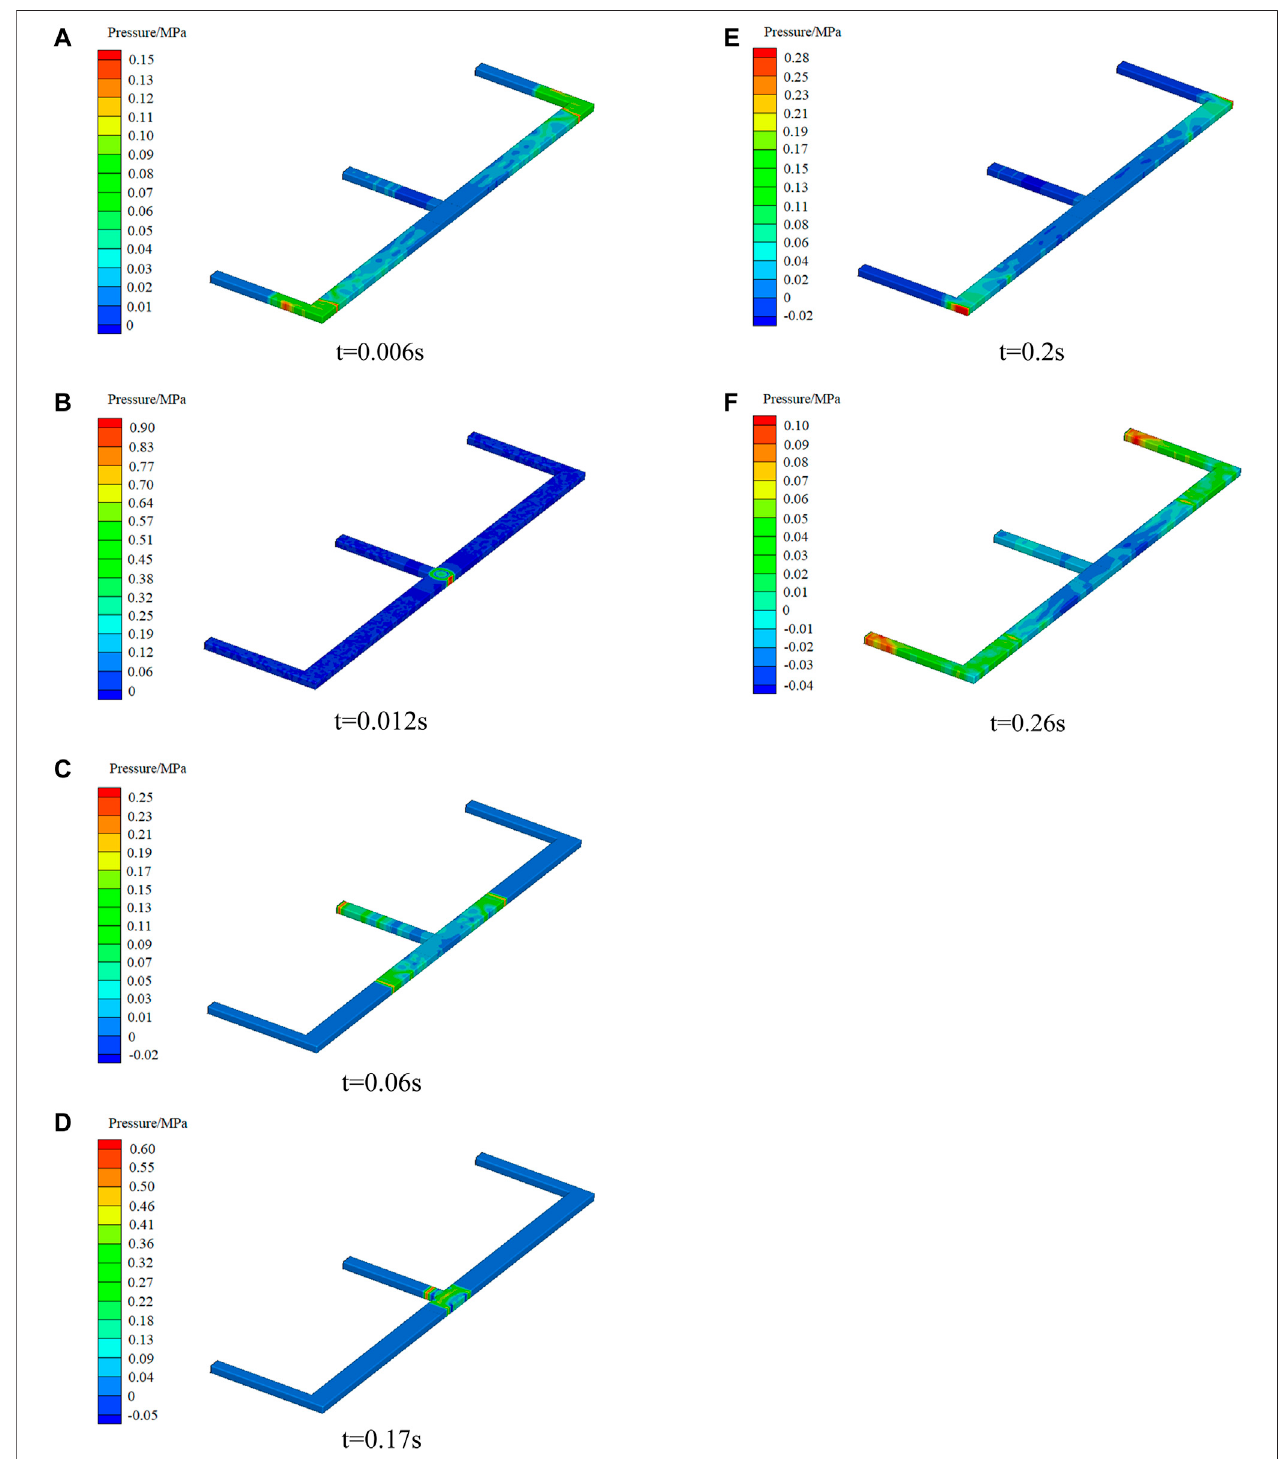
FIGURE 11 | Cloud diagram of shock wave overpressure distribution at different time of gas explosion. (A) t = 0.006 s. (B) t = 0.012 s. (C) t = 0.06 s. (D) t = 0.17 s. (E) t = 0.2 s. (F) t = 0.26 s.